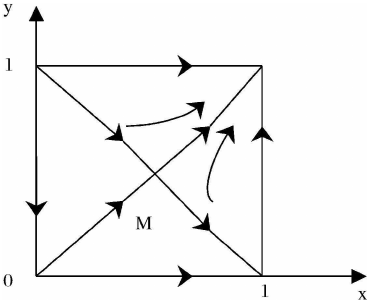
Fig. 2 Evolutionary phase diagram 2